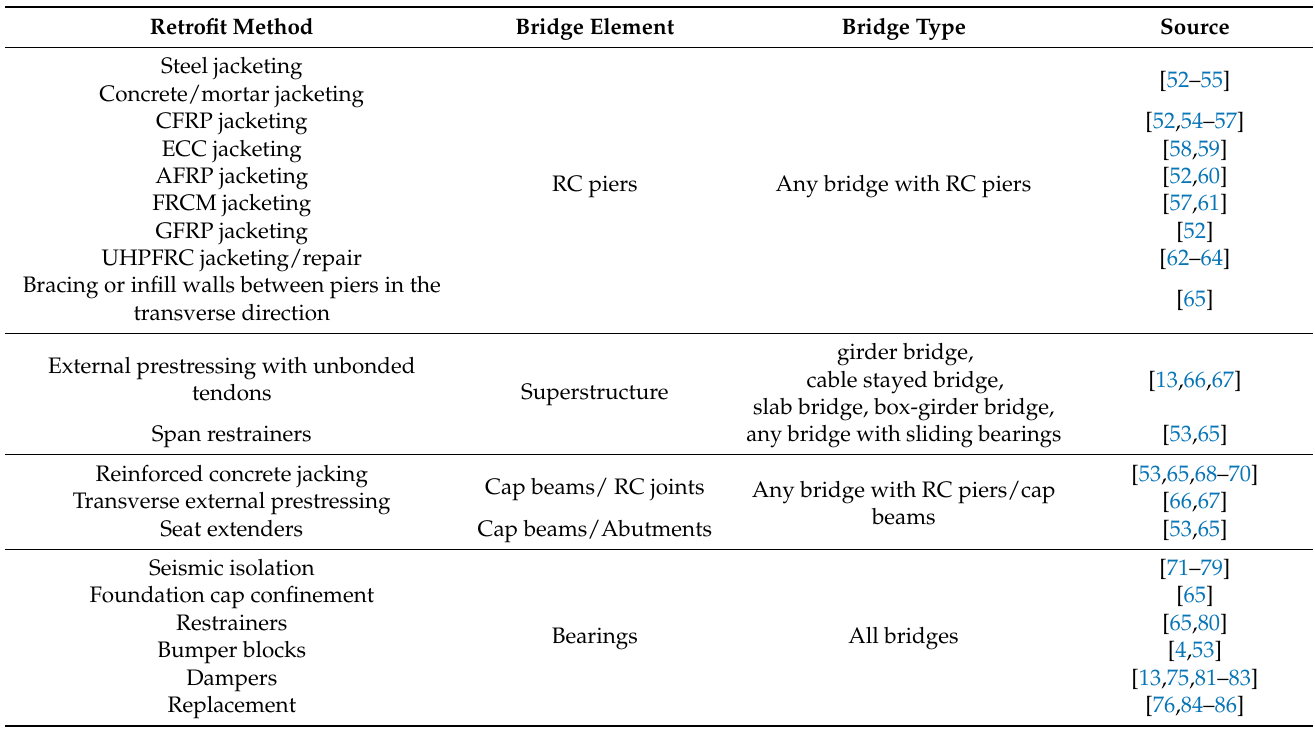
Table 2. List of common methods for seismic retrofitting of existing road